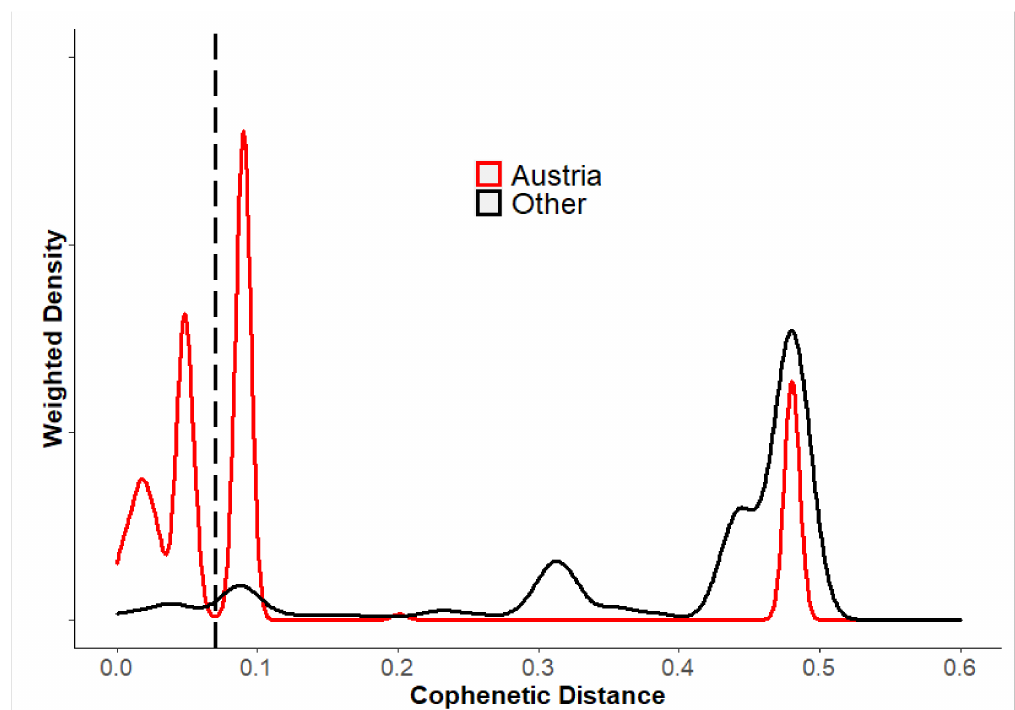
Figure 4. Probability density curves of cophenetic distances based on partial Puumala orthohantavirus (PUUV) S segment maximum clade credibility tree. The phylogenetic tree was based on 144 partial (505 nt) sequences of PUUV S segments from rodent reservoirs ( Clethrionomys glareolus ) across Europe, including five from C. glareolus and 57 from human patients in Austria, 2012–2019, using the GTR+G+I substitution model. The curves are smoothed histograms showing the pairwise cophenetic distance densities from the subset of Austrian sequences (red) and all other sequences (black, File S2 excluding the reference sequence ( Tula orthohantavirus , NC_005228, distance >1.0). The curve height is scaled (“weighted density”) for ease of visualisation and comparison. The dashed vertical line shows the threshold of 0.07 used to differentiate the two genotypes of Alpe-Adria PUUV described in